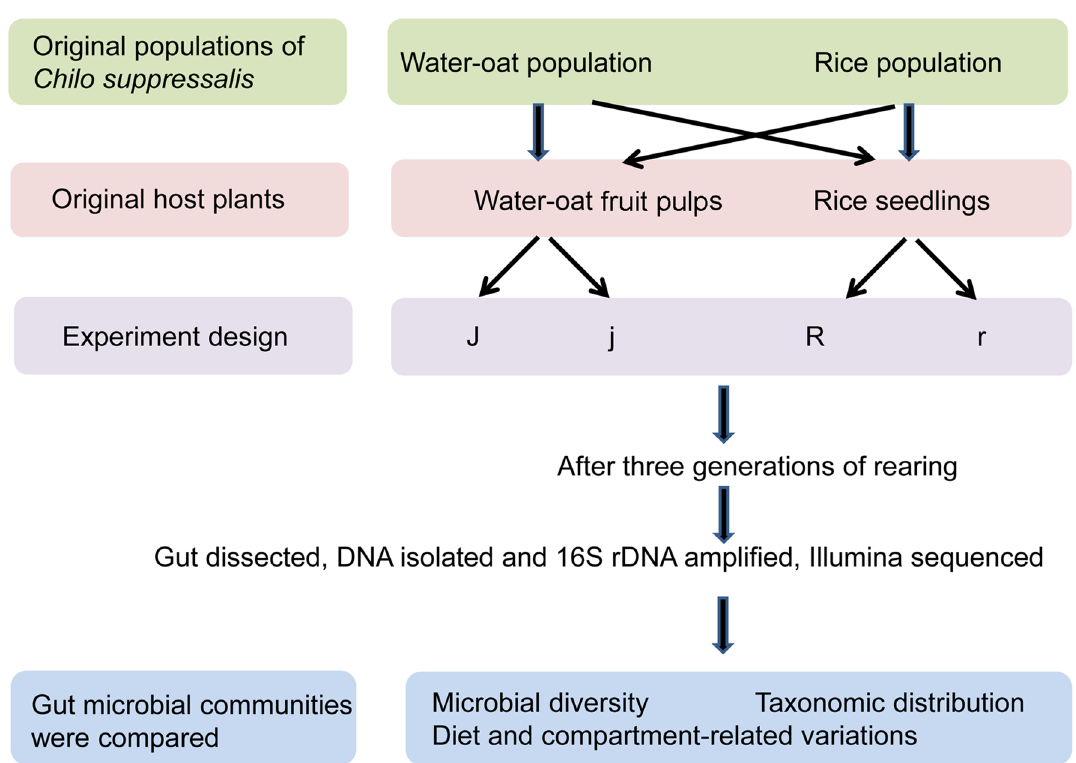
Figure 1. Schematic diagram of the fully factorial experimental design used in the present study. Chilo suppressalis from water-oat field and rice field were reared on water-oats fruit pulps or rice seedlings for three continuous generations to examine the effects of host plant and population origin on the gut microbiota. There were two cross-rearing populations (i.e., non-original populations) comprised of water-oat population individuals reared on rice seedlings (j) and rice population individuals reared on water-oat fruit pulps (r). The corresponding original populations were water-oat population individuals reared on water-oat fruit pulps (J) and rice population individuals reared on rice seedlings DNA isolation, 16S rDNA amplification. Total bacterial genomic DNA was extracted from eight sets of sample groups using a Soil DNA Kit (Omega Bio-tek, Norcross, GA, U.S.) according to the manufacturer’s instructions. The DNA was finally eluted with TE buffer (Tris–EDTA buffer). DNA purity and concentration were measured using the NanoDrop 2000 spectrophotometer (Nano-drop Technologies, Wilmington, DE, USA). The total DNA was stored at − 70 °C until use. The bacterial 16S rRNA variable V3−V4 regions were used to identify bacteria. Two universal primers (341F and 806R) containing the specific barcode sequence were used for the amplification of the V3−V4 regions (341F: